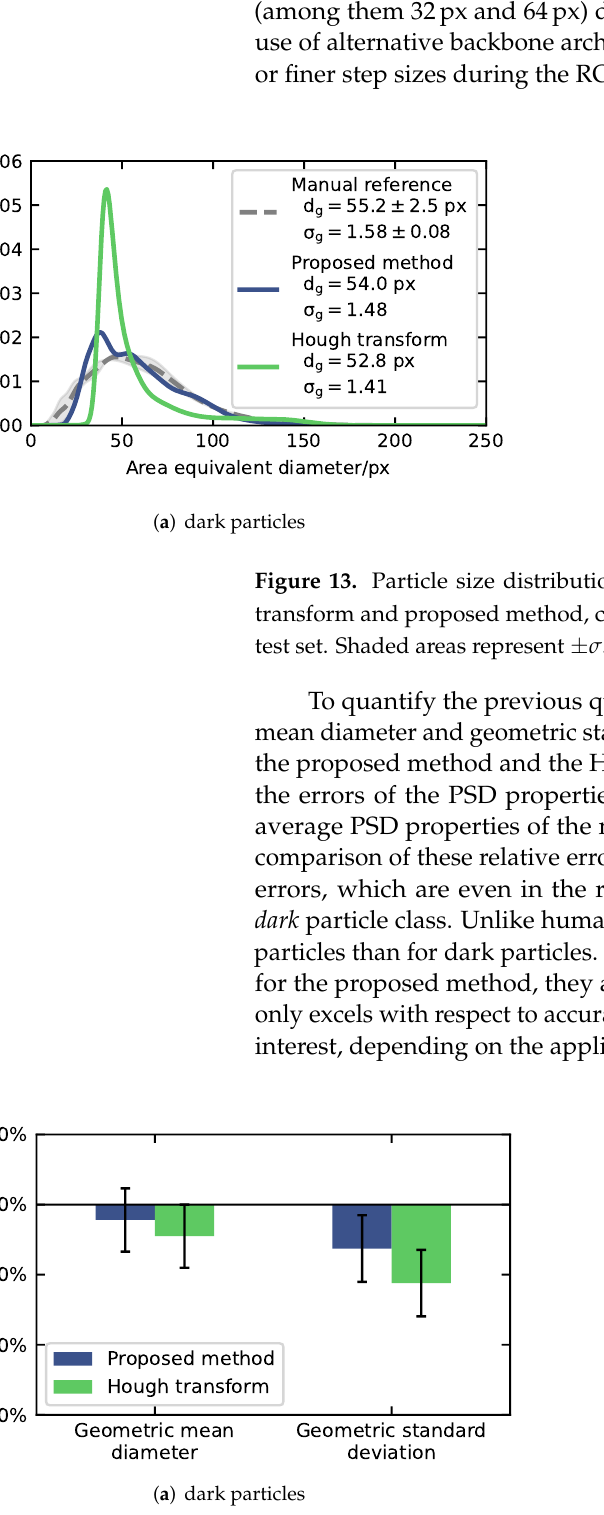
Figure 14. Relative errors of geometric mean diameter d g and geometric standard deviation σ g of particle size distributions of dark ( a ) and light ( b ) particles, as predicted by Hough transform and proposed method, compared to averaged manual reference, when being applied to test set. Error bars represent ± σ of averaged manual